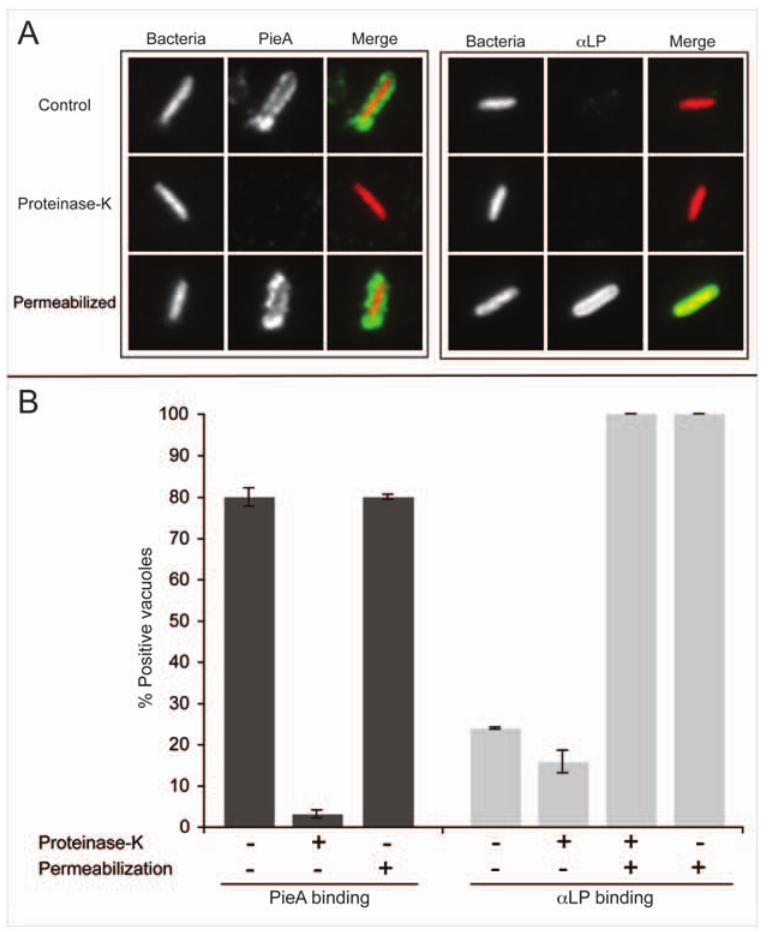
Figure 7. PieA binds to the cytoplasmic face of vacuoles containing L.pneumophila , in a mechanism dependent upon protein– protein interaction. Representative epifluorescence micrographs of L. pneumophila vacuoles isolated from U937 macrophage-like cells infected with a pieA mutant strain expressing the fluorescent protein DsRed. (A) L. pneumophila containing vacuoles that were treated with PK to eliminate surface exposed protein epitopes (Proteinase-K), lost their ability to bind PieA (PieA), as compared to vacuoles treated under the same conditions without PK (Control). PK treated vacuoles remained intact and their content remained inaccessible to an antibody directed against L. pneumophila ( a LP), unless the vacuoles were first permeabilized using cold methanol (Permeabilzed). (B) The isolated vacuoles were scored to quantify the percent of vacuoles that bound to PieA(513–699) (PieA) or stained positive for L. pneumophila ( a LP). Values are means 6 standard error of mean for three independent experiments in which 300 vacuoles were scored for each